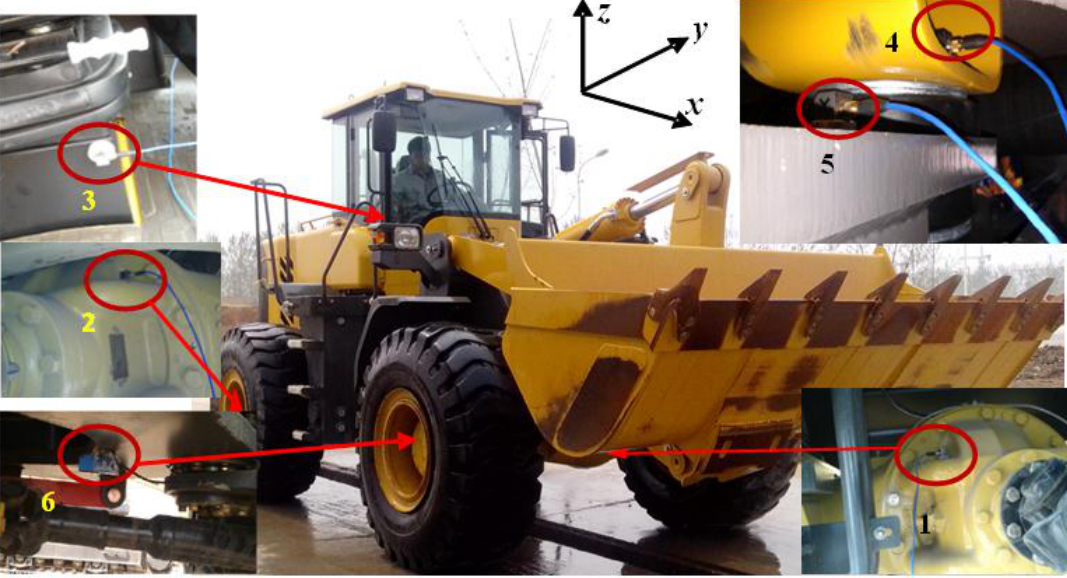
Figure 3. Vibration test site: 1—Front axle housing, 2—Rear axle housing, 3—Seat bracket, 4—Before cab mount, 5—After cab mount, 6—Front axle input shaft.